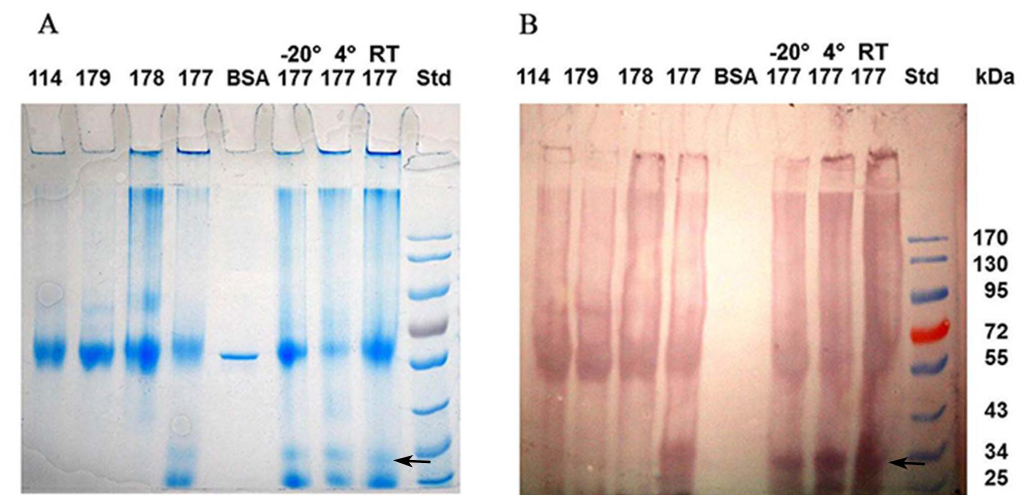
Figure 2. Visualization of quinone-protein adducts by using a quione-specific nitro blue tetrazolium staining. The Coomassie blue- stained gel of proteins of different honeys and that of buckwheat honey (H177) stored at room temperature (RT), 4 u C and 2 20 u C ( A ) and its corresponding electroblot stained with the quinone-specific nitro blue tatrazolium ( B ) BSA was used as a control for quinone-staining specificity. The arrow indicates a position of the 31 kDa protein.